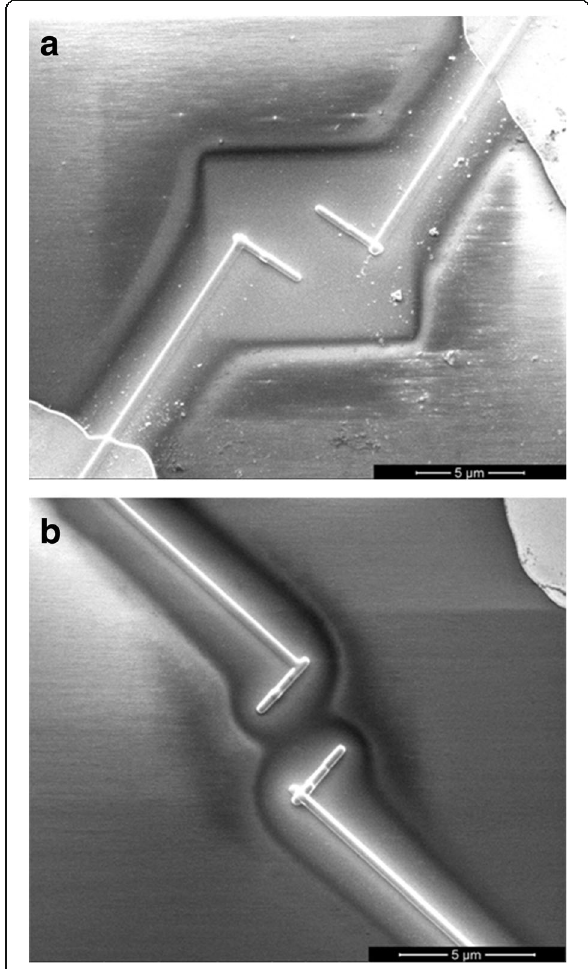
Fig. 2 SEM images taken at 1 kV of acceleration voltage of fake devices consisting in couples of Pt electrodes. This e-beam setting allows us to highlight the surface contamination. The relief appearance is due to the electrical charging of the insulating surface. This effect also makes the scanning lines of the e-beam visible. In the areas where the lines are not visible, the surface results to be conductive. a A square on the device longer exposed to the FIB is evident, denoting a strong contamination in that region. On the other hand, in b , representing the short exposed device, any structure due to the FIB exposure is detectable. In both